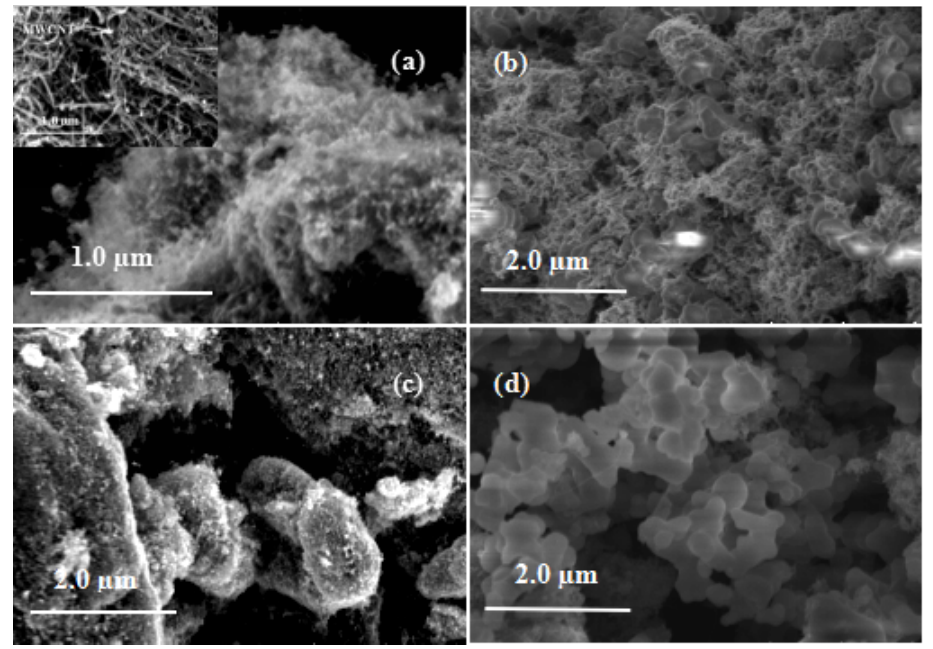
Figure 3. FESEM morphologies of ( a ) MWCNTs@ZnO nanocomposites, ( b ) C1, ( c ) C2 and ( d )